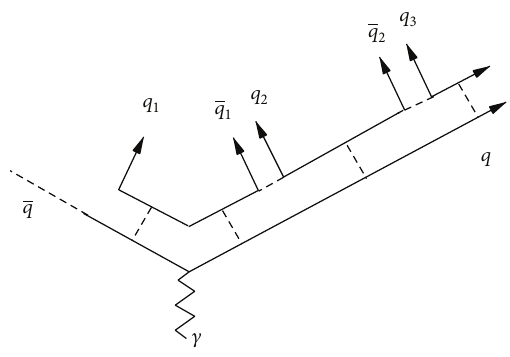
Figure 1: String breaking through 𝑞𝑞 pair